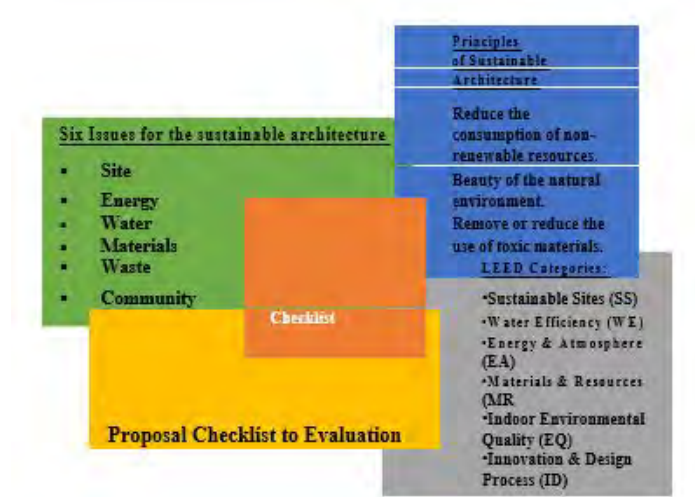
Figure 4. Guide elements for the search about Checklist.